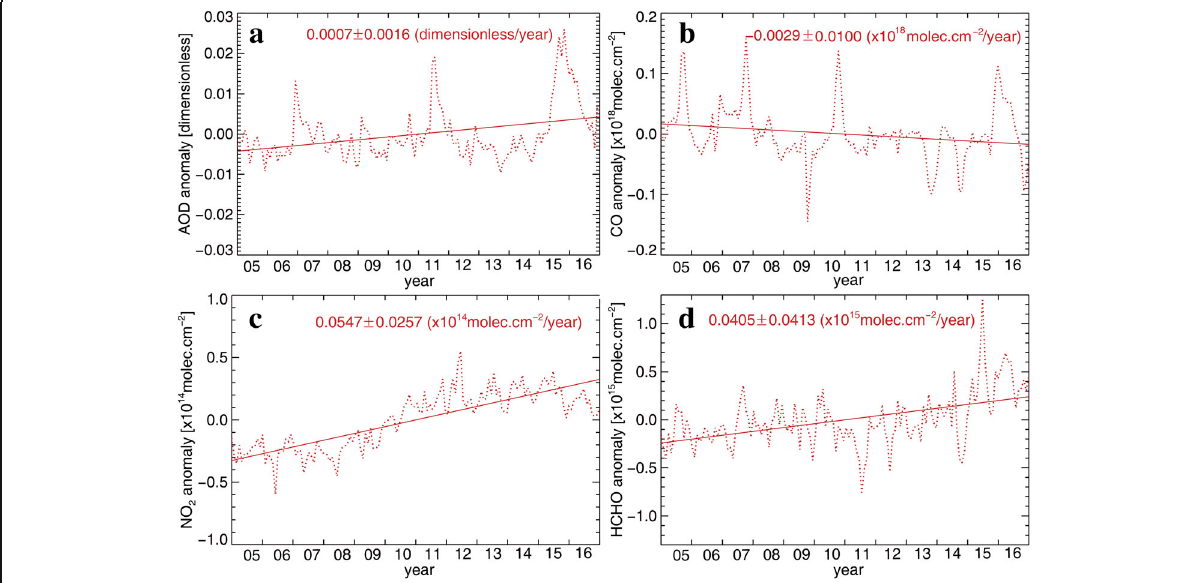
Fig. 6 Time-series (dotted line) and the linear trend (solid line) of monthly mean deseasonalized anomalies of a AOD at 550 nm, b CO total column density, c NO 2 tropospheric column density, and d HCHO tropospheric column density. All measures are for the Southern Hemisphere (30 – 60° S) from 2005 to